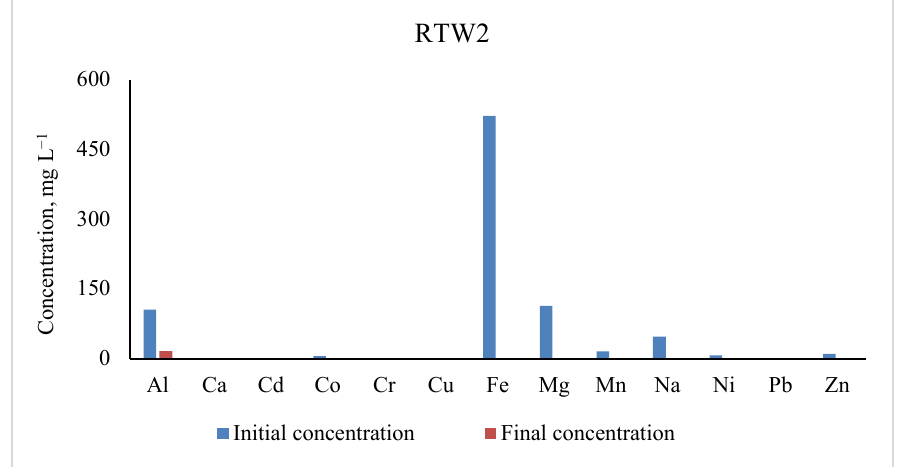
Figure 8. Initial and residual concentrations of metals in water sample collected from RTW2. Contrary to sampling site RTW1, Cd was not detected in this AMD sample, but the Pd concentration was 12 times the SANS 241-2015 guidelines ( ≤ 10 µ g L − 1 ). The initial con-